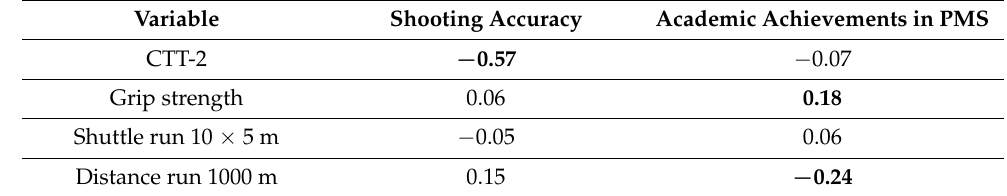
Table 3. Results of regression analysis (progressive stepwise method) of cadets’ shooting accuracy